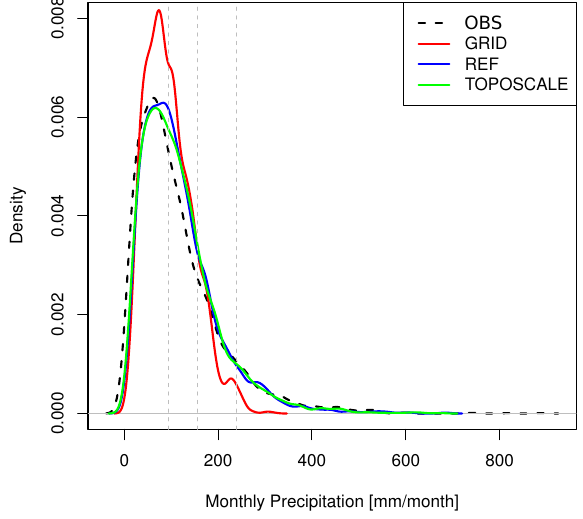
Fig. 8. PDF of GRID, REF and TopoSCALE precipitation schemes with respect to OBS. Data is monthly precipitation sums over all valid stations. Vertical lines correspond to 25–75% quantiles of to- tal precipitation mass (OBS). Simulation of high intensity events is improved by REF and TopoSCALE over GRID